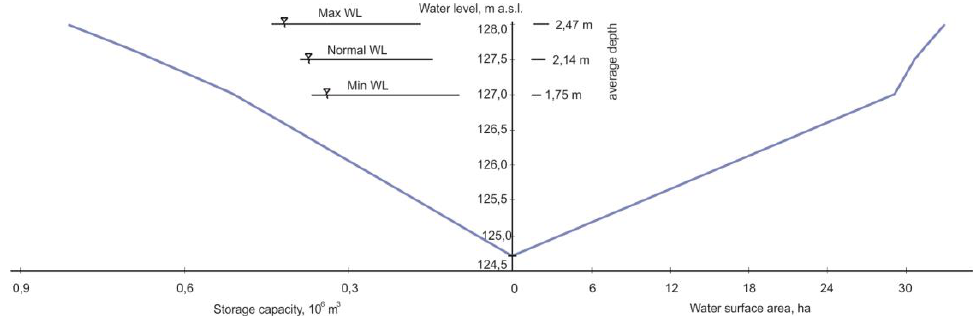
Figure 3. Piaski-Szczygliczka Reservoir storage capacity and water surface area curves.